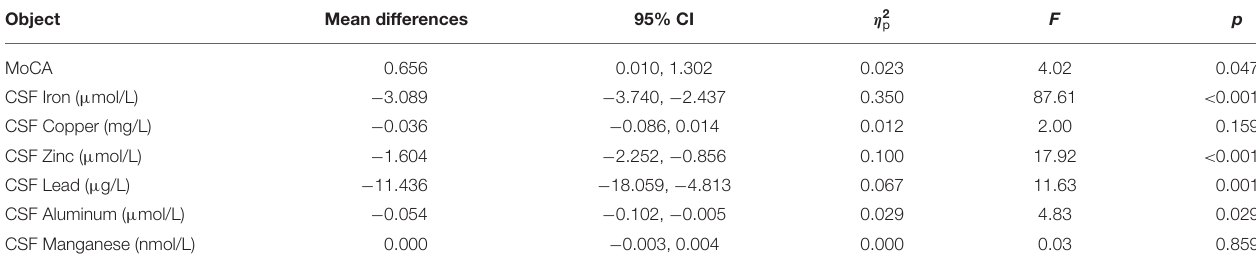
TABLE 2 | The differences of MoCA and metal levels between non-smokers and active smokers.